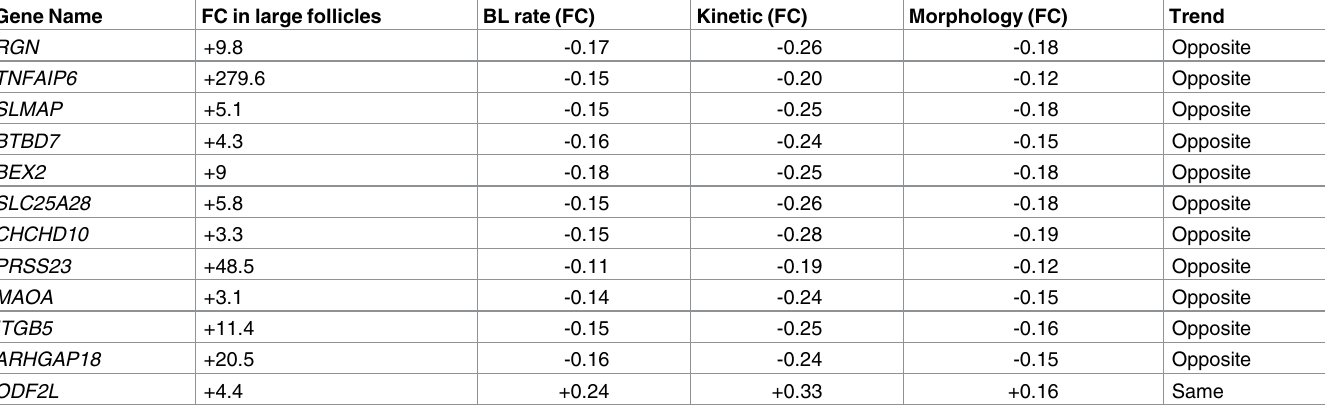
Table 4. Comparison of FCs of significant genes with expression changes identified between small and medium or large antral